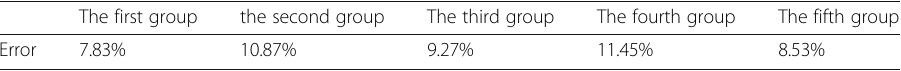
Table 7 The difference between the original signal and the recovery signal The first group the second group The third group The fourth group The fifth group Error 7.83% 10.87% 9.27% 11.45%